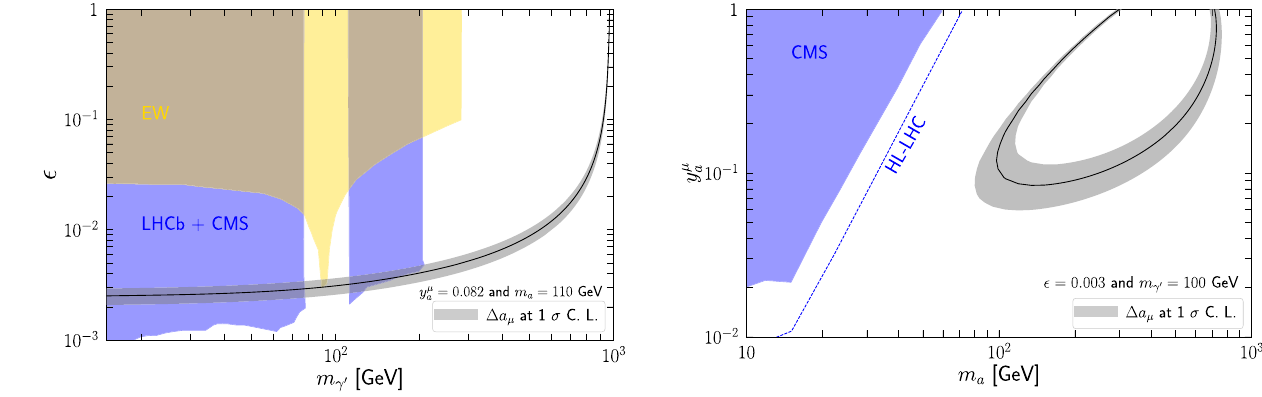
sitivities at Belle II (green dashed line) and HL-LHC [68] (blue dashed